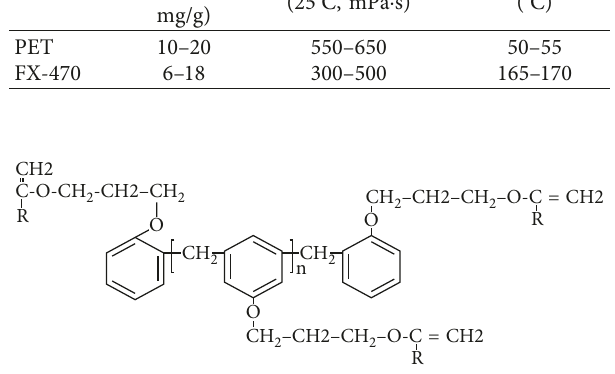
Figure 1: Phenol-aldehyde-epoxy-type vinyl ester